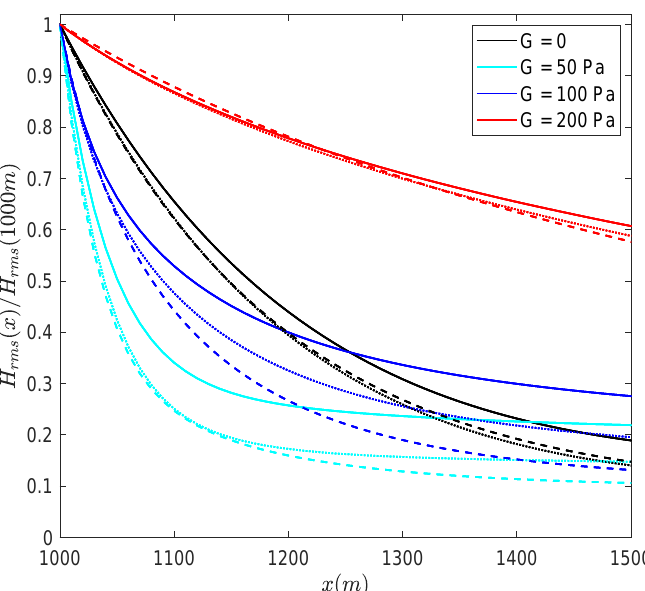
Figure 13. Spatial variation of random wave height, H rms , over viscoelastic mud with shear moduli of G = 0–200 Pa in presence of currents with Fr = +0.15 (solid line), Fr = 0 (dot line), and Fr = − 0.15 (dashed line). Simulation parameters are the same as those in Figure 12 but the spectral peak frequency is 0.28